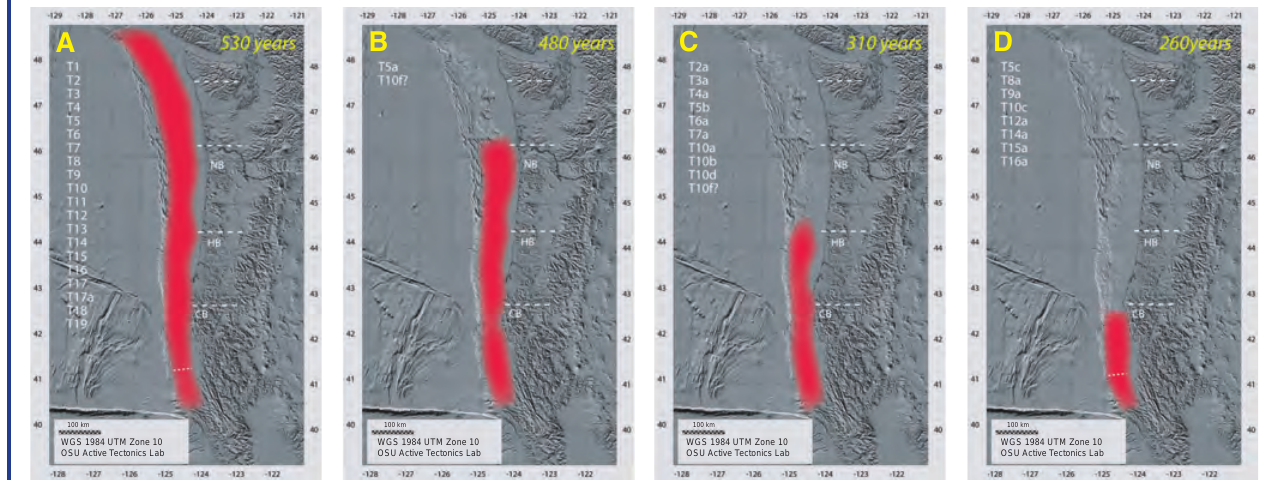
Figure 5. Holocene rupture lengths of Cascadia great earthquakes from marine and onshore paleoseismology. Four panels showing rupture modes inferred from turbidite correlation, supported by onshore radiocarbon data: [A] full rupture, represented at all sites by twenty turbidites; [B] mid-southern rupture, represented by three events; [C] southern rupture from central Oregon southward represented by eight events; [D] southern Oregon/northern California five events. Southern rupture limits vary, as indicated by white dashed lines. Recurrence intervals for each segment are shown, and include all full margin events as well as those exclusive to that segment. Rupture terminations are approximately located at three forearc structural uplifts: Nehalem Bank (NB), Heceta Bank (HB), and Coquille Bank (CB). Paleoseismic segmentation is also compatible with latitudinal boundaries of episodic tremor and slip events (Brudzinski and Allen, 2007), shown by white dashed lines (adapted from Goldfinger et al., 2008).